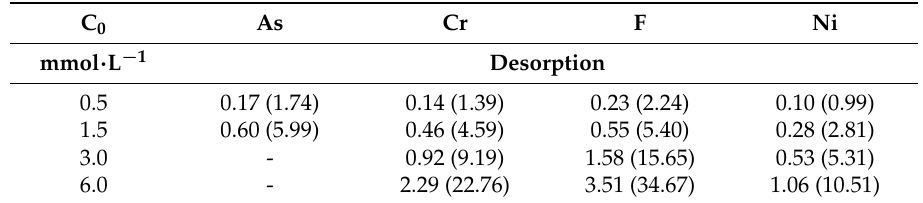
Table 4. As, Cr, F, and Ni desorption in mmol · L − 1 (and mmol · kg − 1 between brackets) from wheat straw for different concentrations